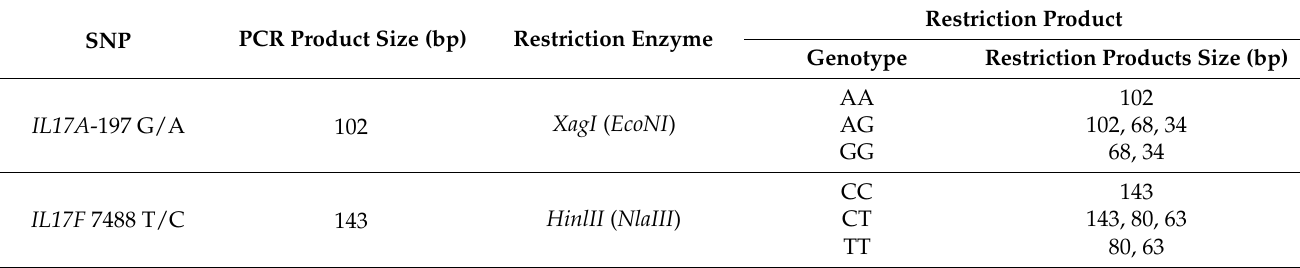
Table 1. PCR products, restriction fragments size and the respective genotypes for the IL17A and IL17F SNPs.